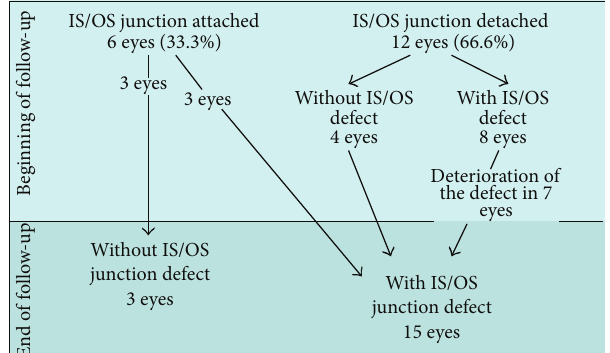
Scheme 2: Follow-up results in the control